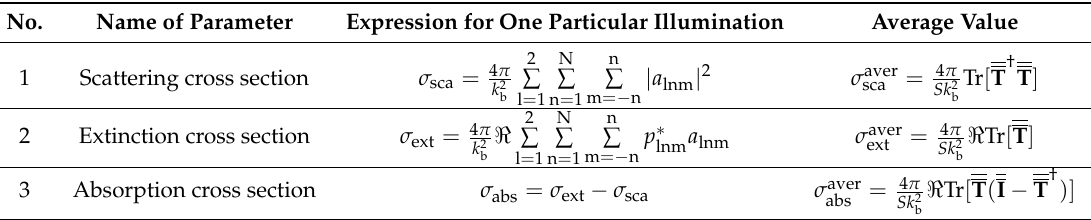
Table 1. Mathematical expression for a particular illumination as well as the average value extracted from the parity based T-matrix of the meta-atom for various